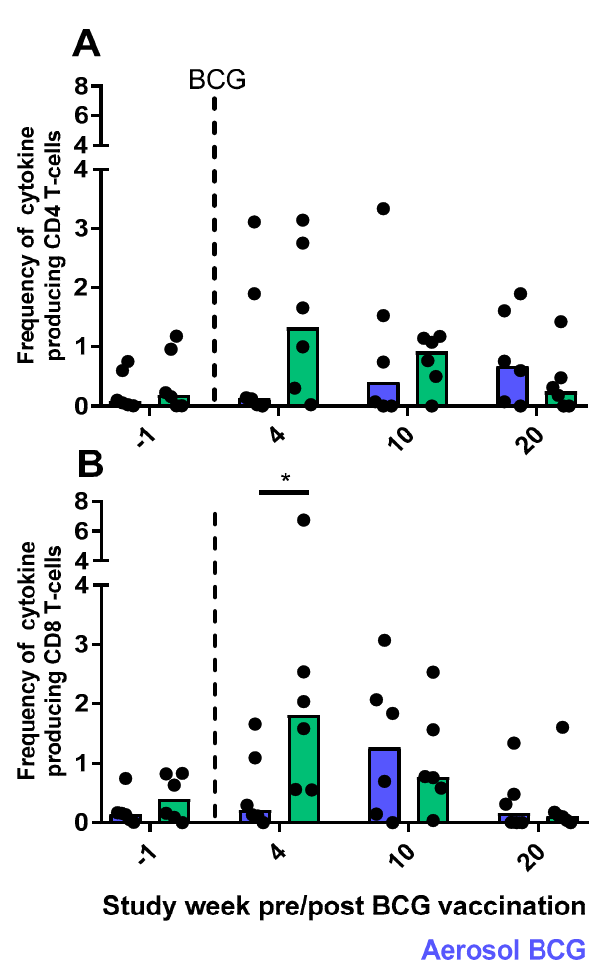
Figure 10. Total PPD specific-cytokine production by CD4 and CD8 T-cells. Dots represent the summed frequency of CD4 ( A ) and CD8 ( B ) T-cells producing IFN- γ , IL-2, TNF- α or IL-17 measured in peripheral blood mononuclear cells (PBMCs) collected from individual animals prior to (week -1) and following aerosol (blue bars) or intradermal (green bars) BCG. Bars show the group medians with significant differences determined by Mann–Whitney U-test indicated by an asterisk, p ≤ 0.05.